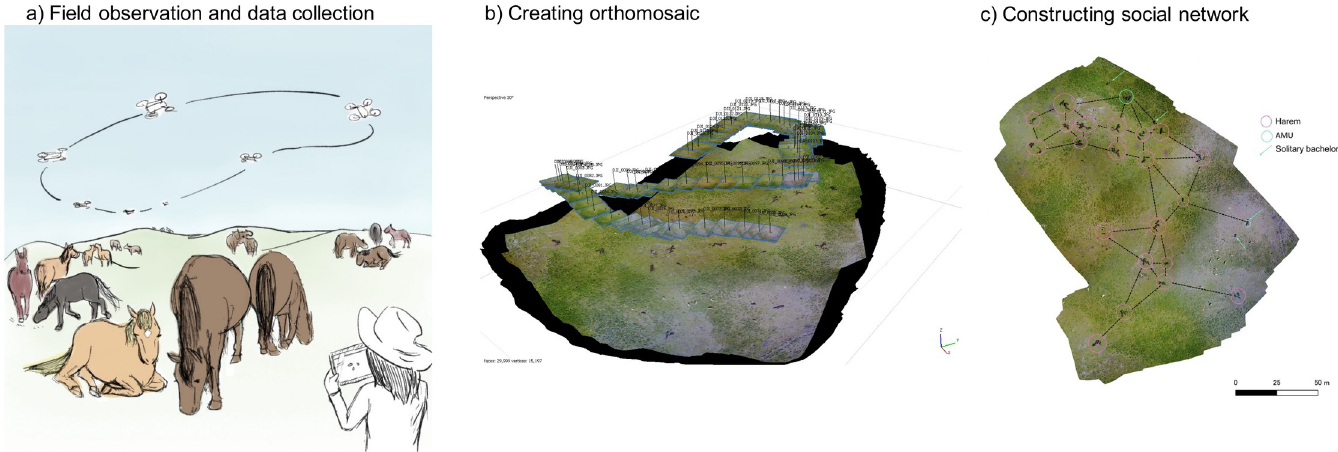
Fig 2. Overall research procedure. (a) Aerial photos of horses were taken using drones. (b) These successive photos were stitched together to create an orthomosaic. (c) Individuals in orthomosaics were identified, and the positional and behavioural data of horses were obtained. The social network was then constructed using inter- individual distance data. The photograph is also used in Maeda et al., (2021) published in Scientific Reports.